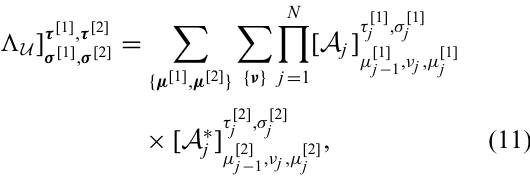
Fig. 4. With a standard contraction strategy for tensor net- works, calculations of M time. By using caching [32,45] one can complete this task in amortized O ( 1 )